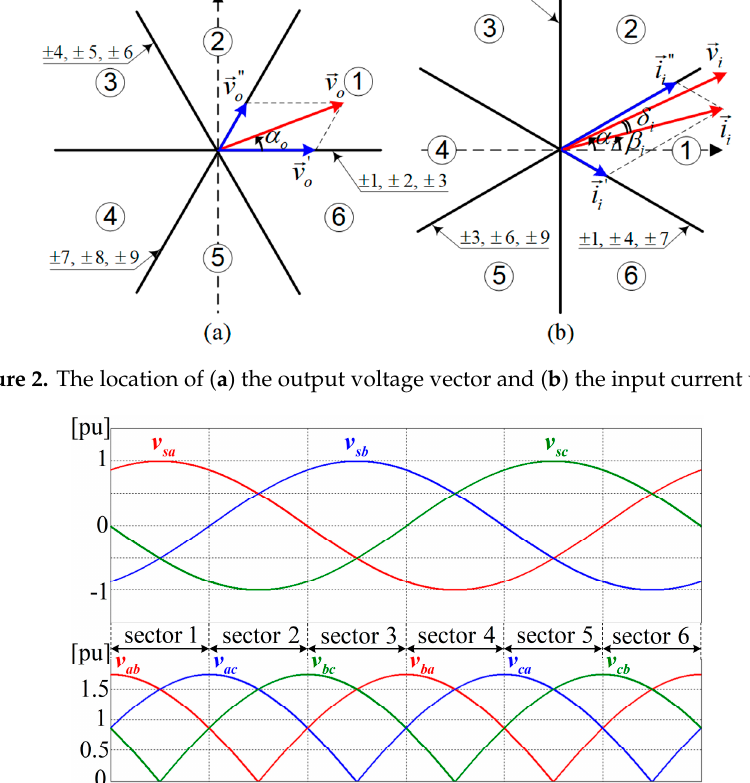
Table 2. Selected active-vector states for each combination of output voltage and input current sectors in the traditional space vector modulation method.